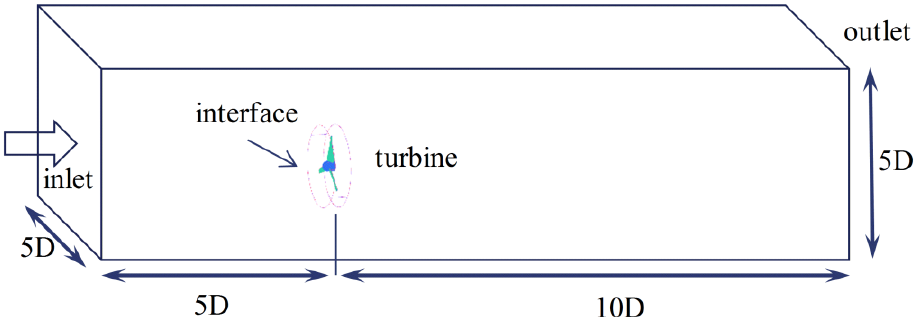
Figure 5. Schematic view of the computational domain.